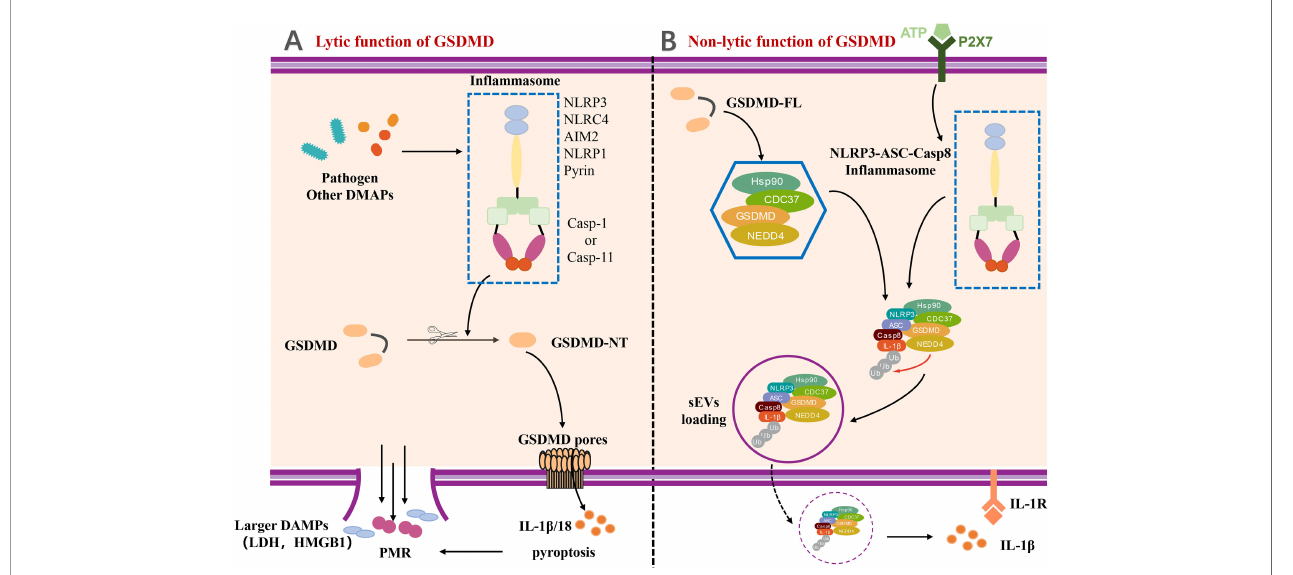
FIGURE 2 | The lytic and non-lytic function of GSDMD. (A) The lytic function of GSDMD. Various in fl ammasome activated by pathogen and other DAMPs and further cleaved GSDMD to induce GSDMD-NT. With the oligomerization of GSDMD-NT, GSDMD pores formed and eventually resulted in plasma membrane rupture (PMR). IL-1 b and other larger DAMPs released by lytic function of GSDMD. (B) The non-lytic function of GSDMD. A complex containing full-length GSDMD, chaperoned by the Hsp90 and CDC37, NEDD4 (an E3 ligase), and caspase-8, was formed in LPS-induced YAMC epithelial cells. The complex along with active caspase-8 and NEDD4 catalyzed polyubiquitination of pro – IL-1 b induced release of IL-1 b via sEVs by non-lytic function of GSDMD. DAMP, damage-associated molecular pattern; LDH, lactate dehydrogenase; HMGB1, high mobility group protein B1; PMR, Plasma membrane rupture; P2X7, P2X7 purinergic receptor; Hsp90, Heat Shock Protein 90; CDC37, cell division cycle protein 37; NEDD4, Neuronal precursor cell Expressed Developmentally Downregulated 4; sEVs, small extracellular